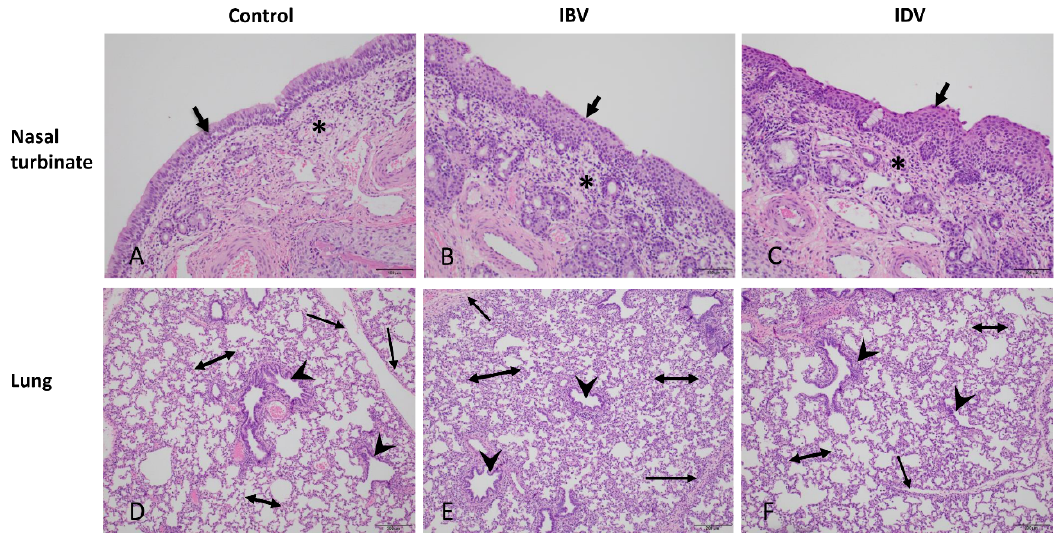
Figure 2. Histologic nasal turbinate and lung sections from pigs infected with either IBV or IDV at 8 days post-infection. Top Row : Nasal turbinate sections from control and infected pigs. Turbinate from control ( A ) have normal ciliated respiratory epithelium (arrow) and minimal inflammatory cells in lamina propria (asterisk). The IBV ( B ) or IDV ( C ) infected nasal turbinates have prominent segment of squamous epithelium / metaplasia (arrow) with infiltrating neutrophils through lamina propria and epithelium and increased lymphocytes in lamina propria (asterisks). Bottom Row : Lung sections from control ( D ) and infected pigs ( E,F ) taken after collection of lavage. Lungs infected with IBV ( E ) have prominent di ff use interstitial pneumonia with increase in cellularity of alveolar septae (double arrows), along interlobular septae (single arrows), and with prominent (though mild) peribronchiolar lymphocytes (arrowheads). Lungs infected with IDV ( F ) have milder di ff use interstitial pneumonia (increased thickening and cellularity of alveolar septae including along interlobular septae) and minimal peribronchiolar inflammation. Lungs of control pigs have minimal increased cellularity noted components. Bars for nasal turbinate and lung section are 100 and 200 µ m, respectively.